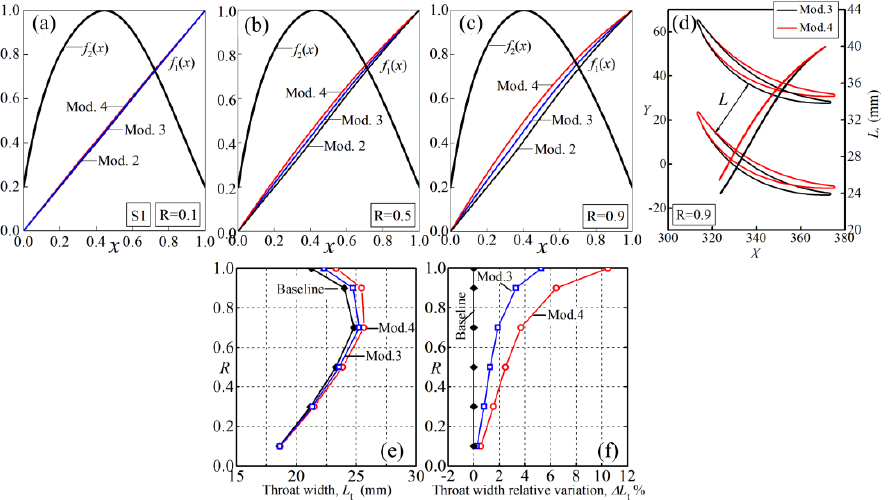
Figure 13. The normalized camber angle distribution f 1 ( x ) and thickness distribution f 2 ( x ) of Mod.2, Mod.3 and Mod.4 ( a – c ); blade airfoil and passage width distribution comparison at R = 0.9 ( d ); blade throat width analysis ( e , f ).